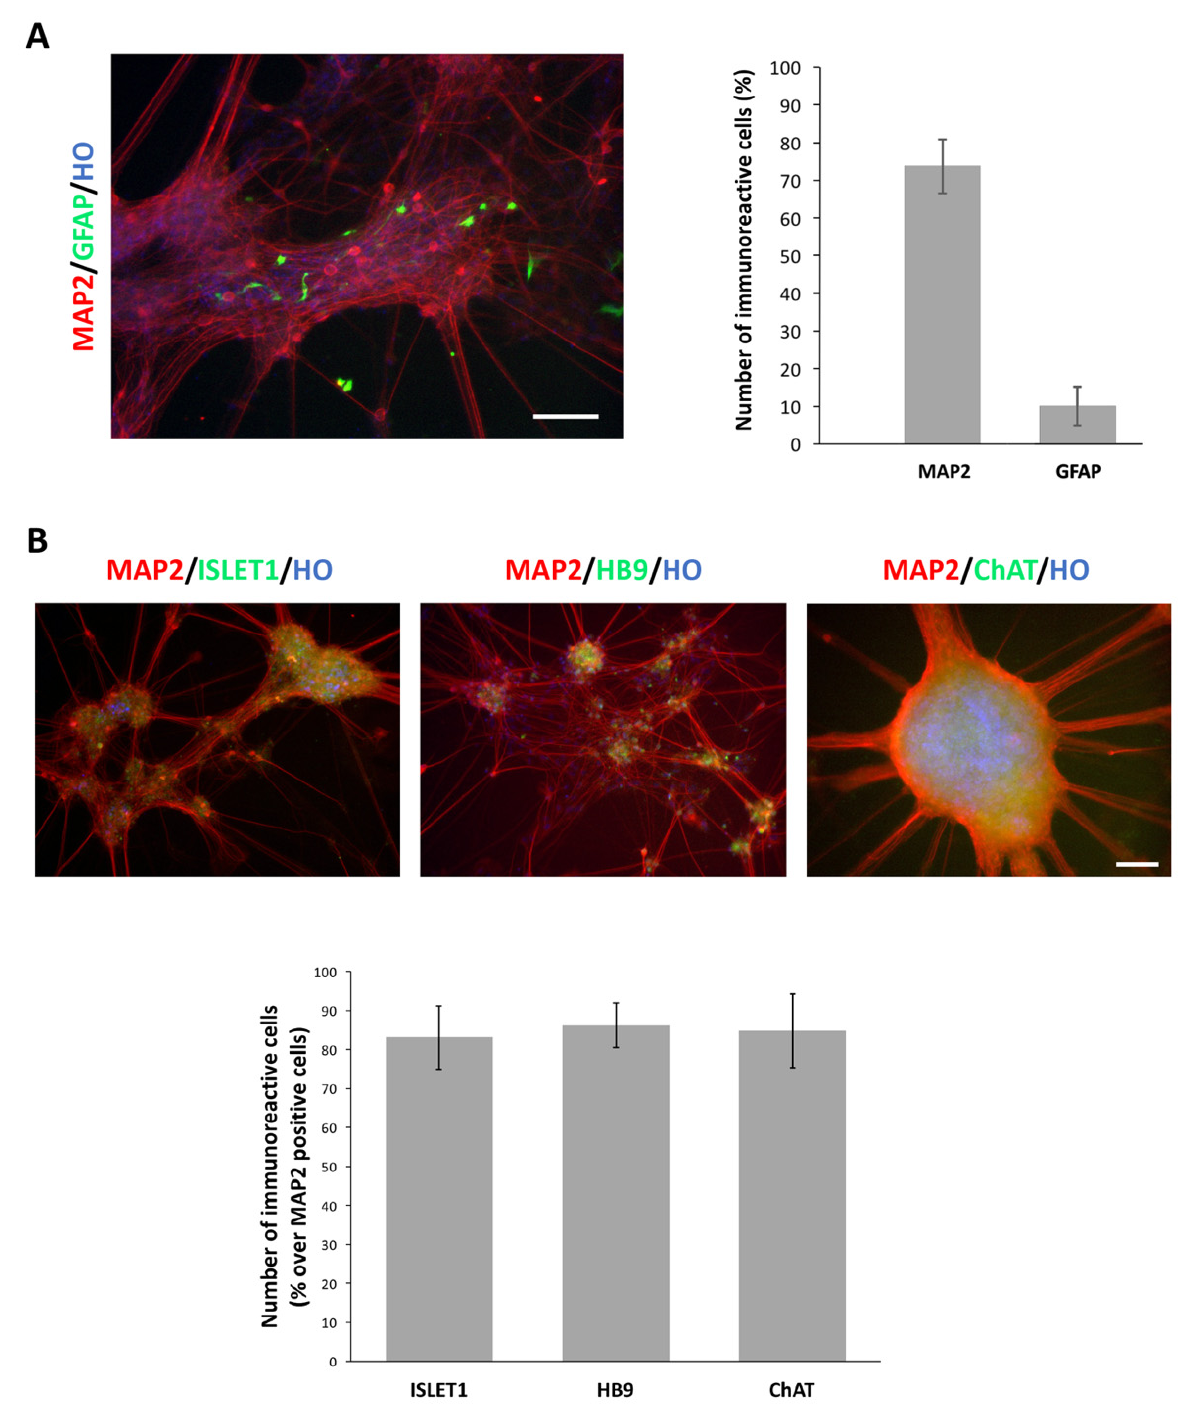
Figure 4. MNs can be long-term maintained in culture. ( A ) Representative picture of MAP2 and GFAP immunoreactive cells in 8-weeks neuronal mature cultures (left panel). Nuclei are stained with Hoechst (HO). Graph reporting the numbers of immunoreactive cells for MAP2 and GFAP at this stage over the total number of cells assessed by HO staining (right panel). ( B ) Representative pictures of MAP2 +ve MNs that co-express ISLET1, HB9 and ChAT (upper panel). Nuclei are stained with Hoechst (HO). Graph showing the number of cells positive for MNs markers over the total number of MAP2 +ve cells (lower panel). Scale bar: 100 μ m. Data are expressed as the means ± STDV ( n = 3 biologically independent experiments).